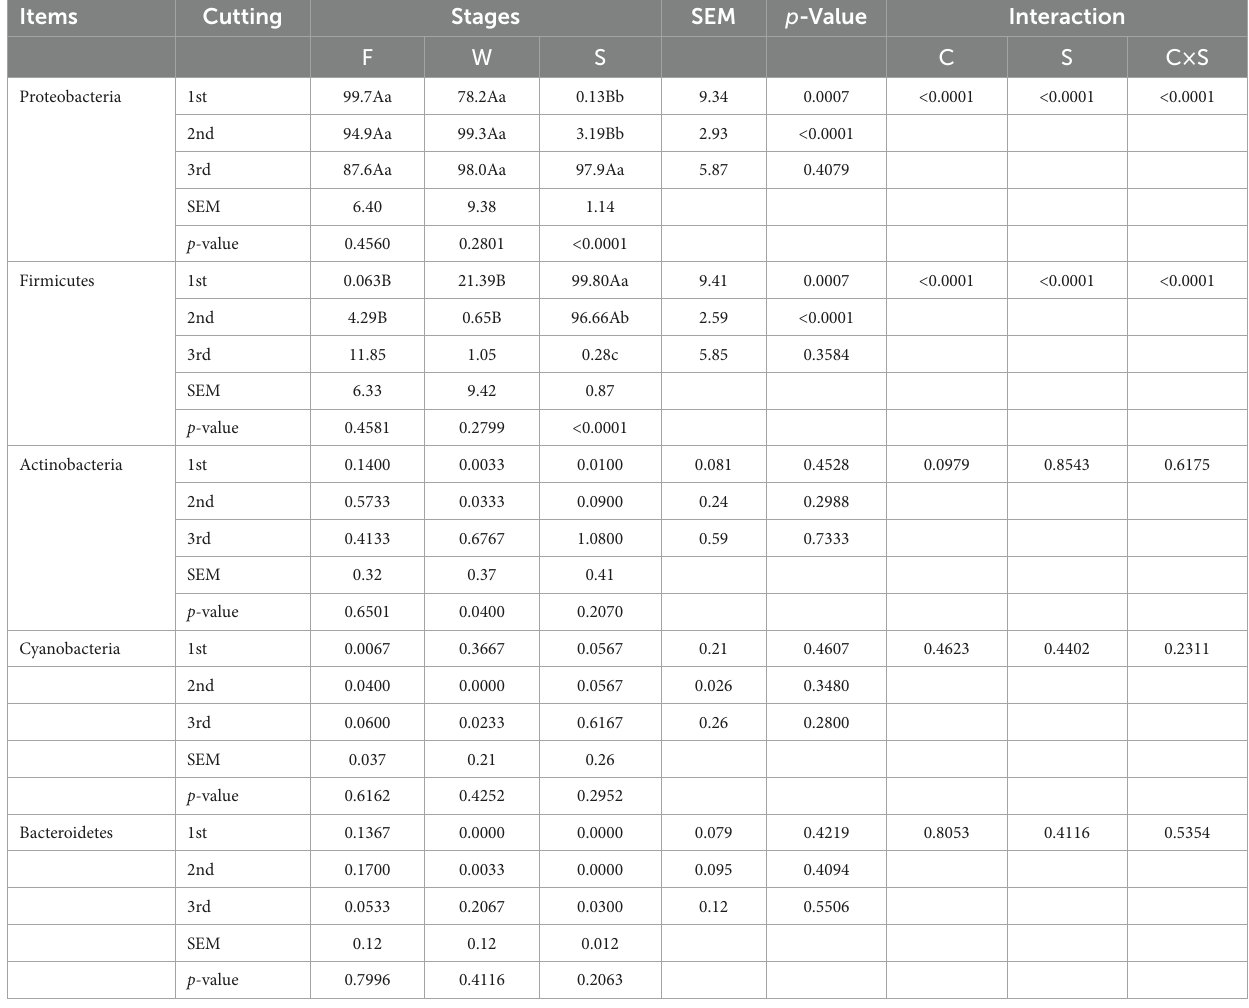
TABLE 1 Relative abundance (%) of the bacterial community at phylum level of fresh, Wilted and ensiled alfalfa at three cuttings.